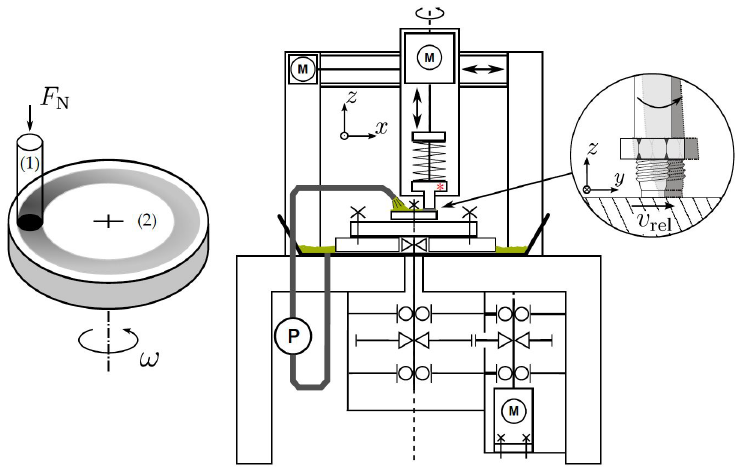
Figure 4. Illustration of the pin-on-disc tribometer taken from Schlarb